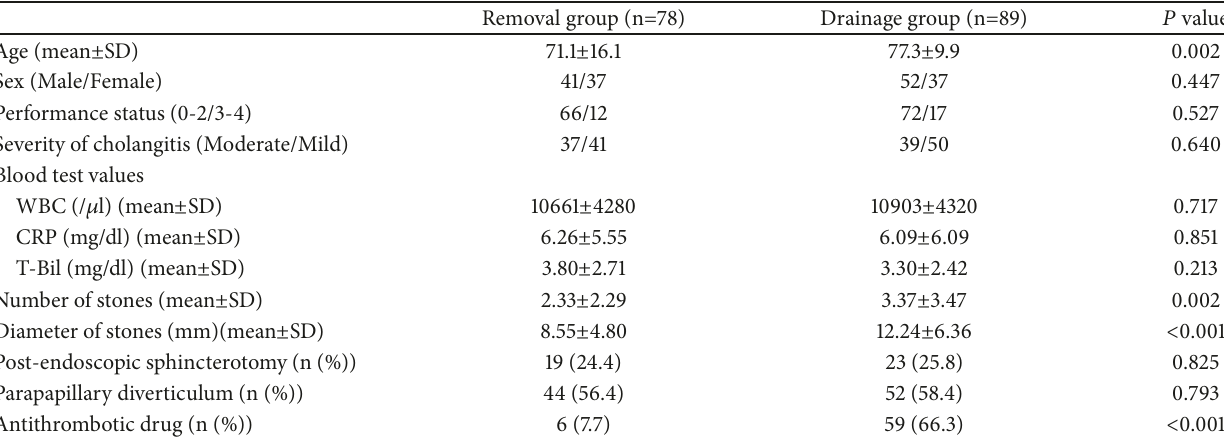
Table 1: Patient characteristics.